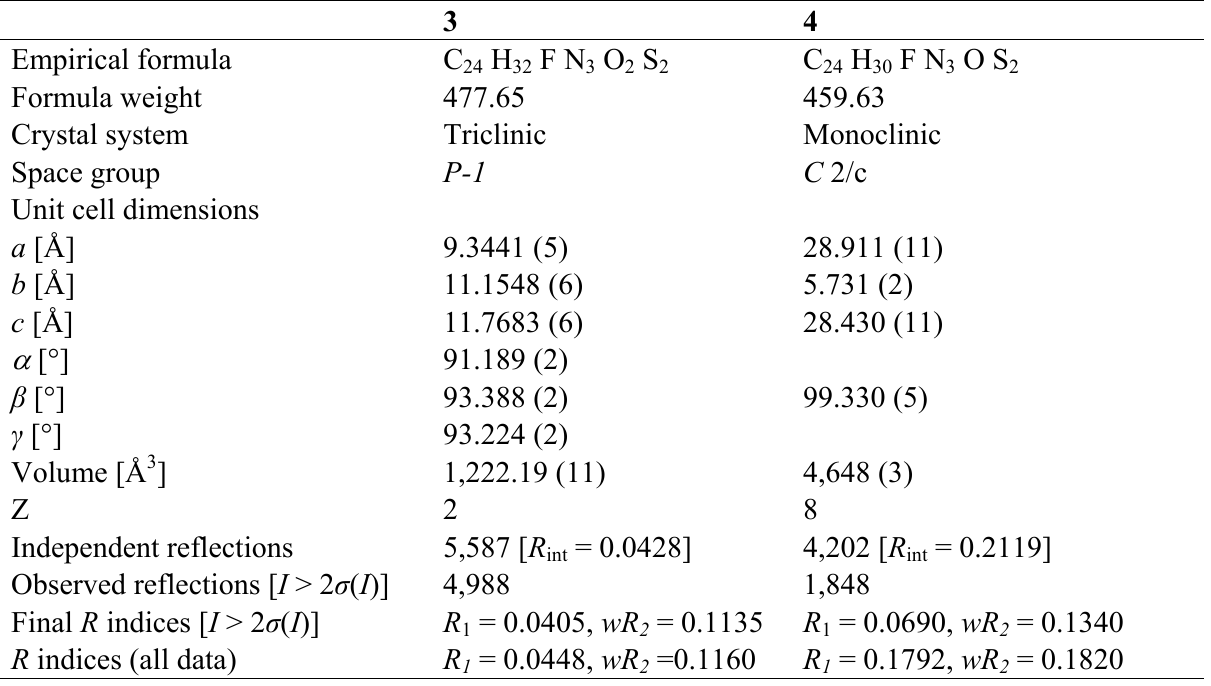
Table 3. Crystal data and refinement parameters for 3 and 4